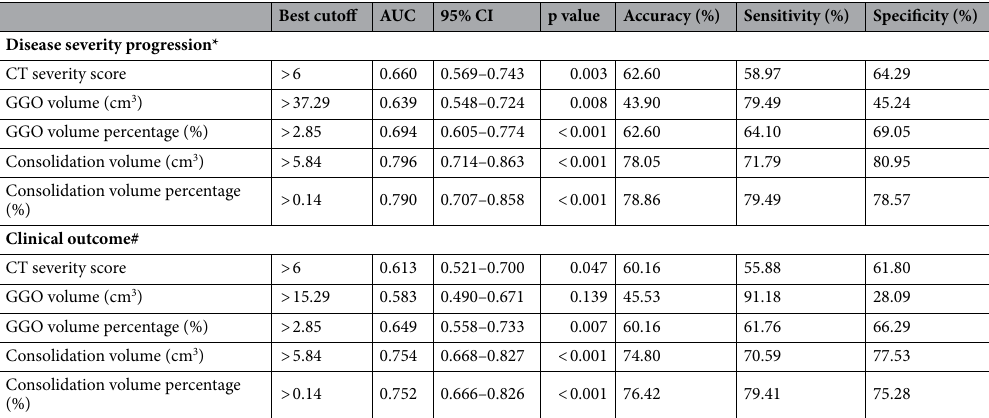
Table 3. ROC curve analysis of CT-derived parameters for predicting disease severity progression and clinical outcome. AUC area under curve, CT computed tomography, CI confidence interval, GGO ground glass opacity, ICU intensive care unit, ROC receiver operating characteristic. *Disease severity progression was defined as the prediction of progress-to-severe group. # Clinical outcome was defined as the prediction of occurrence of critical events (a. respiratory failure and need mechanical assistance; b. shock; c. “extra pulmonary” organ failure, d. ICU